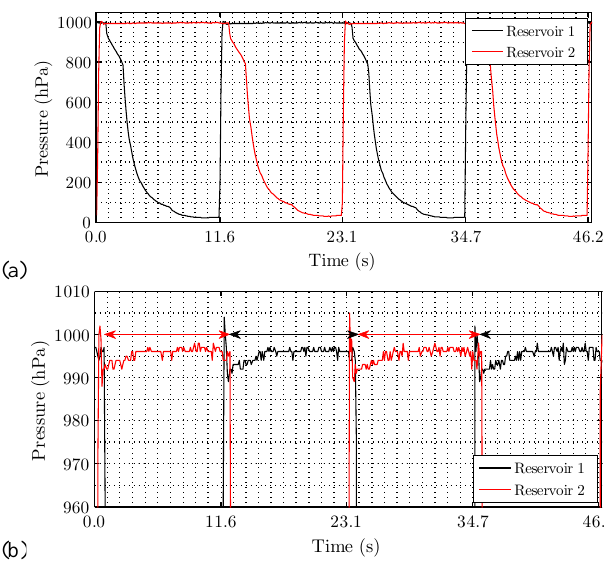
Fig. 5. (a) Pressure (hPa) cycles inside MEDEE’s reservoirs dis- played full scale. (b) The bottom diagram is identical but the pres- sure scale is zoomed around atmospheric value (here 996hPa). The Figure 5: (a) Pressure (hPa) cycles inside MEDEE’s reservoirs displayed full scale. (b) The red and black signals correspond to the two reservoirs. The hori- bottom diagram is identical but the pressure scale is zoomed around atmospheric value (here 996hPa). The red and black signals correspond to the two reservoirs. The horizontal arrows zontal arrows indicate the analysis periods of each sample. Pressure indicate the analysis periods of each sample. Pressure peaks of some hPa are observed at peaks of some hPa are observed at the end of the captures but the the end of the captures but the analyses start later on. analyses start later